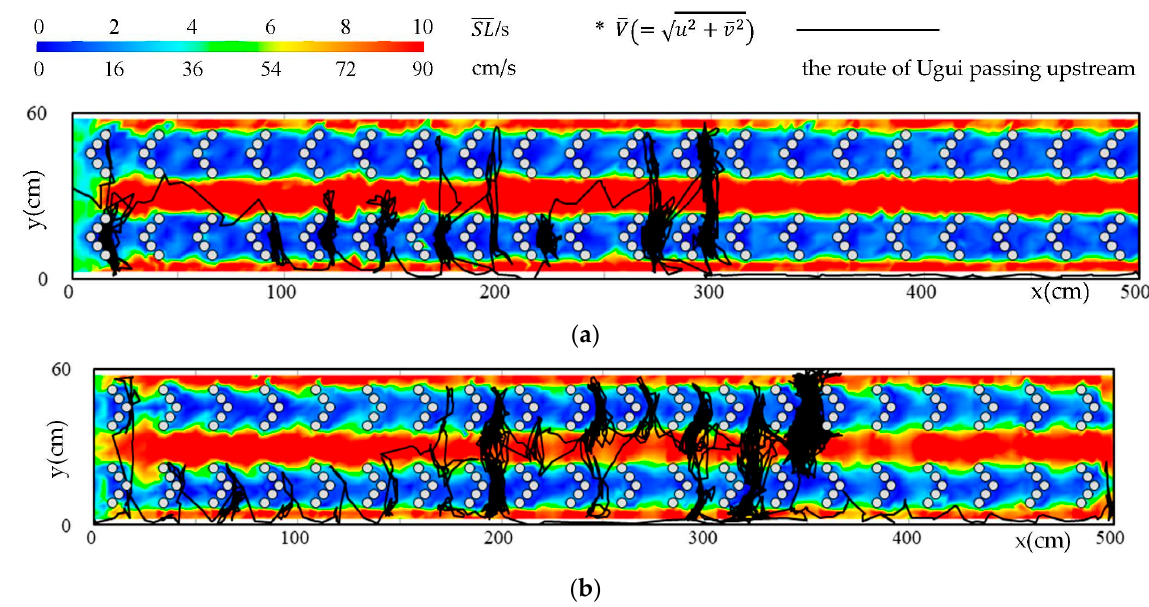
Figure 8. Flow velocity contour diagram of the fishway and the route of Ugui the upstream in each case of the previous study [4]: ( a ) Run4-cu in Case 4; ( b ) Run4-cd in Case 4.